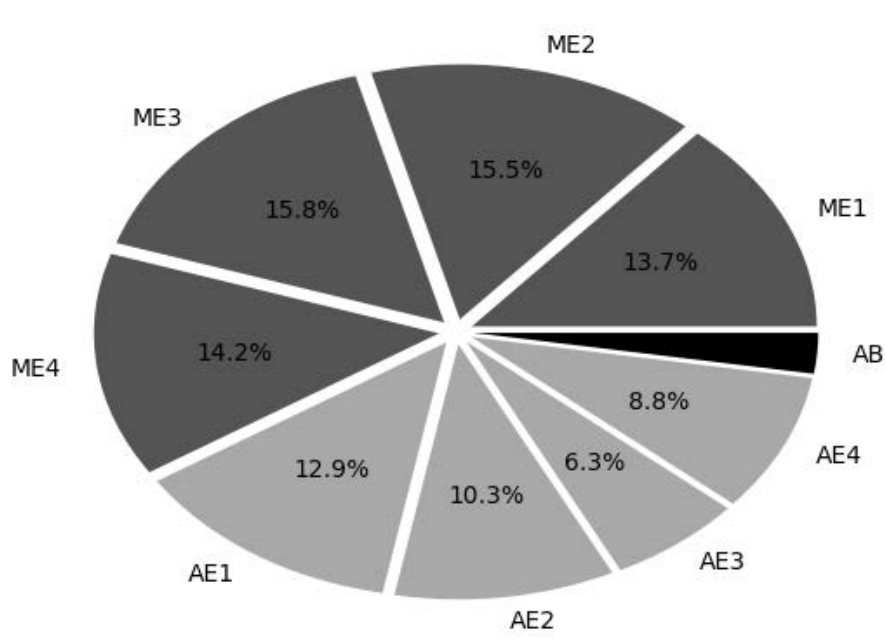
Figure 15. Total ship energy generation for each engine/boiler, aggregated data for one year of operations. Light gray refers to auxiliary engines, dark gray to main engines, and black to the auxiliary boilers.